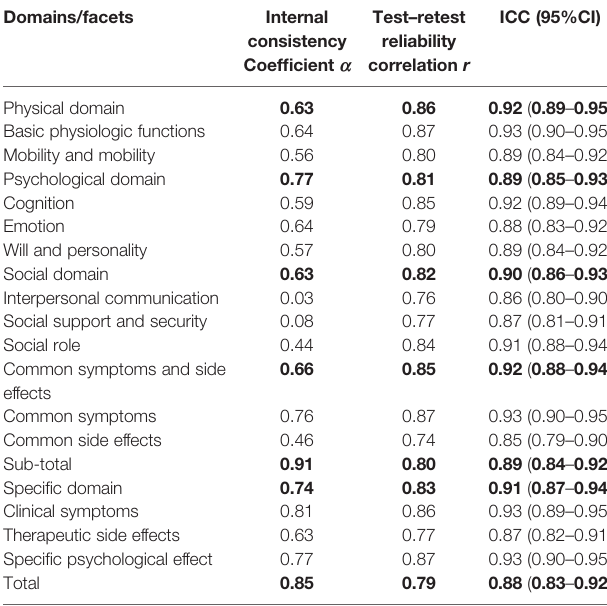
TABLE 1 | Reliability of the quality-of-life instrument QLICP-BR (V2.0) ( n =